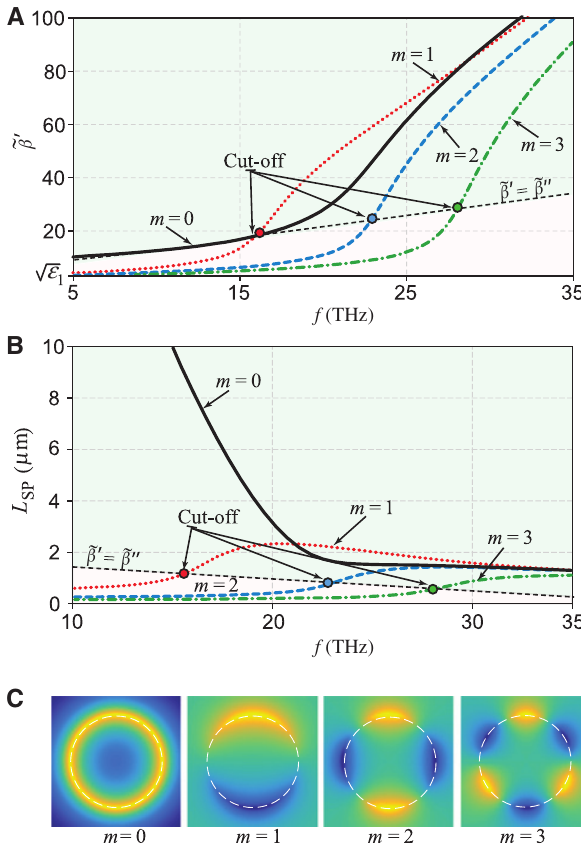
Figure 4: Dispersion characteristics of surface plasmons. (A) Dispersion curves, (B) propagation length, and (C) electric field patterns (real part of the E component) of the TM modes of surface z plasmons in the graphene-coated nanowire for the different azi- muthal mode index m . The areas filled in light green correspond to the regions of propagating modes; a = 50 nm; patterns are plotted at frequency f = 30 THz.